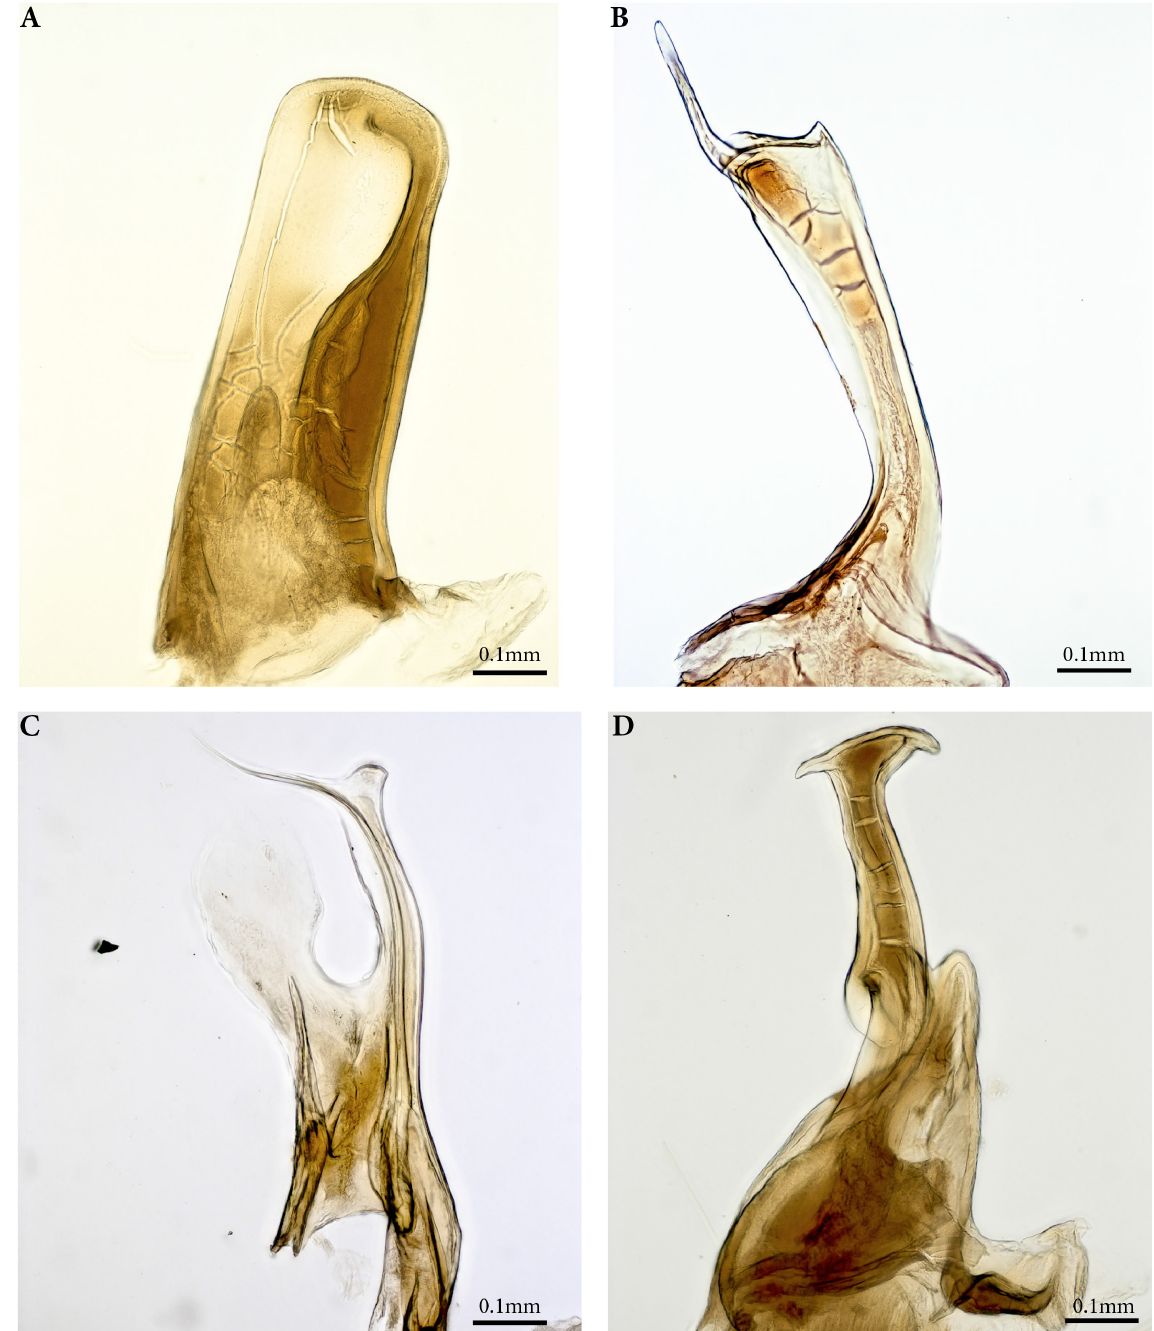
Fig. 16. ‘ Schizophyllum cervinum ’Verhoeff, 1910, syntype, gonopod, slide preparation (ZMB 3896). A . Promerite, posterior view. B . Mesomerite, posterior view. C . Solenomerite, anterior view. D . Paracoxite, anterior